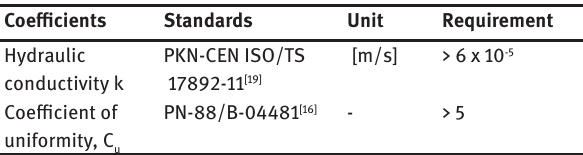
Table 1: Requirements of aggregate for the top layers of the